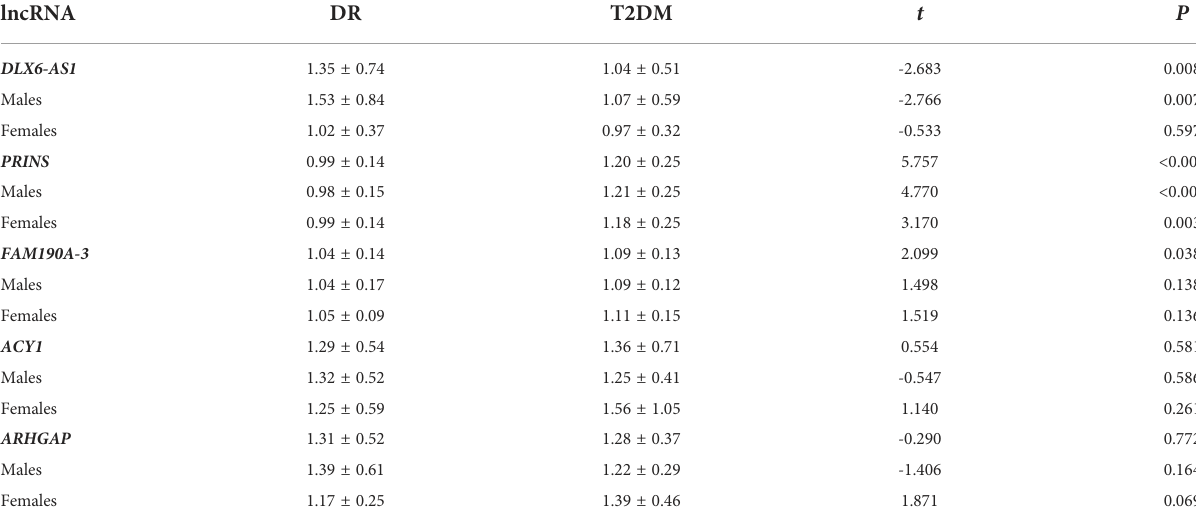
TABLE 2 The differences in expression levels of exosome lncRNA between DR and T2DM groups. lncRNA